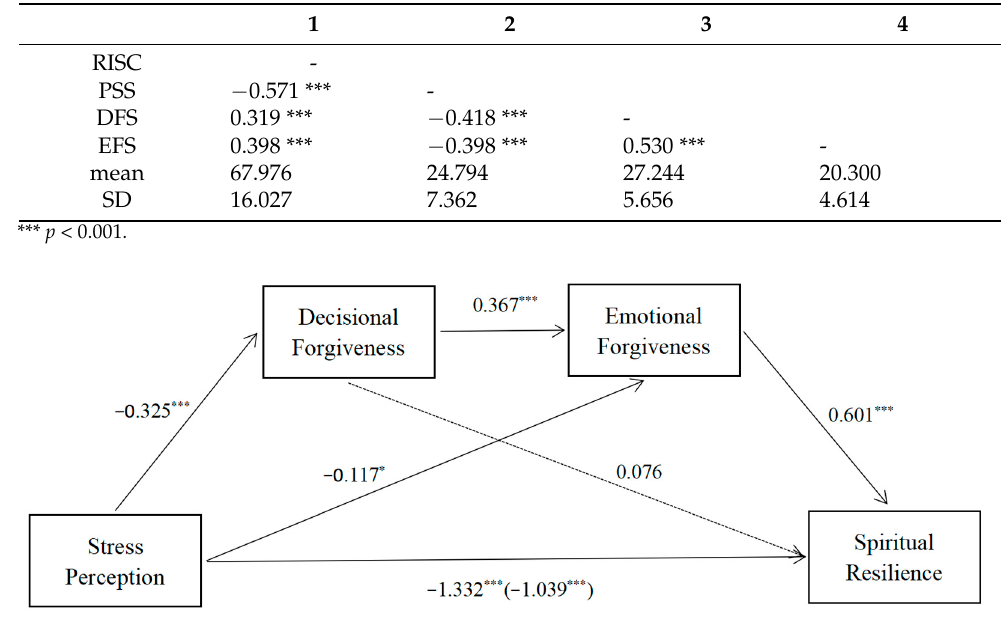
Figure 2. Specific paths and path coefficients for the test model. * p < 0.05, ** p < 0.01, and *** p < 0.001.